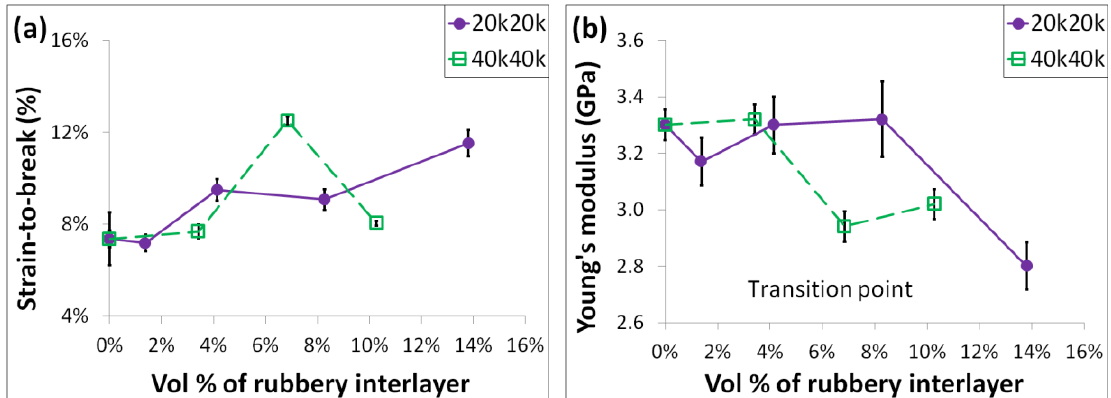
Figure 10. A plot of ( a ) strain-to-break; and ( b ) modulus vs. vol% of PHMA rubbery interlayer for the 20k20k and 40k40k